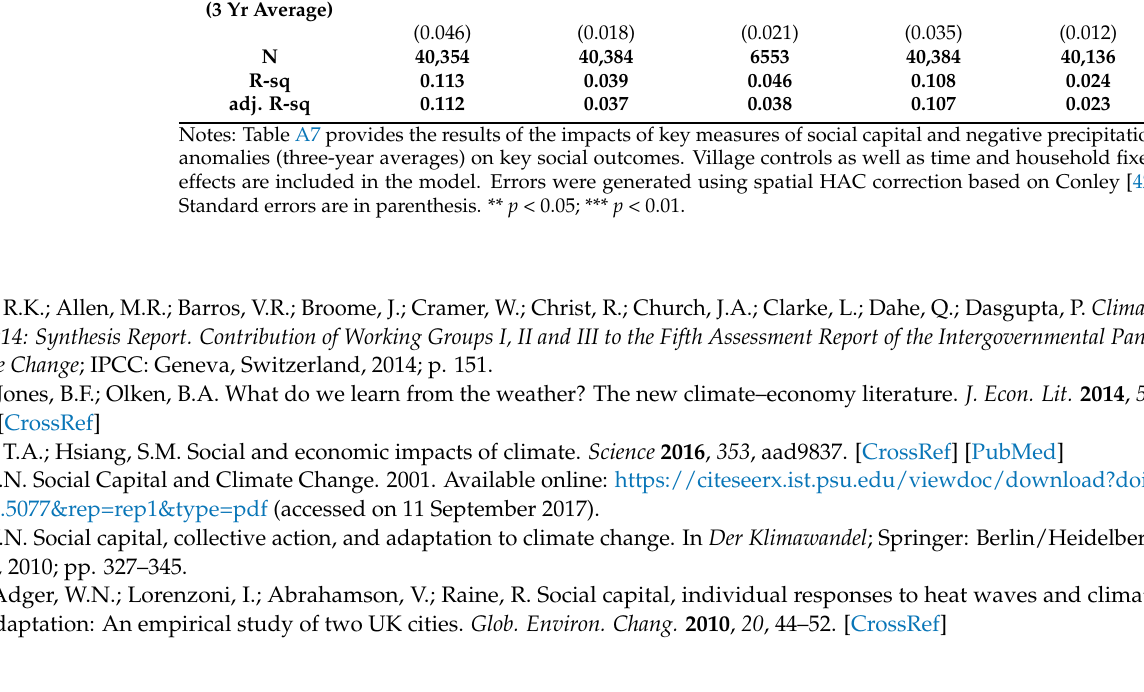
Table A6 reports the results assessing the impacts of negative rainfall shocks on households earning salaried income. Village controls, as well as time, month of survey, and household fixed effects, are included in the model.